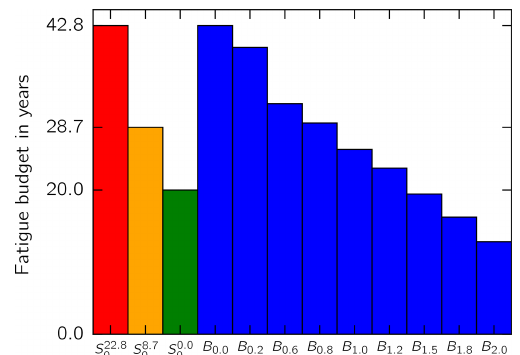
Figure 13. Fatigue budget for the critical turbine component S 0 without RBE and for the blade B l with different RBE